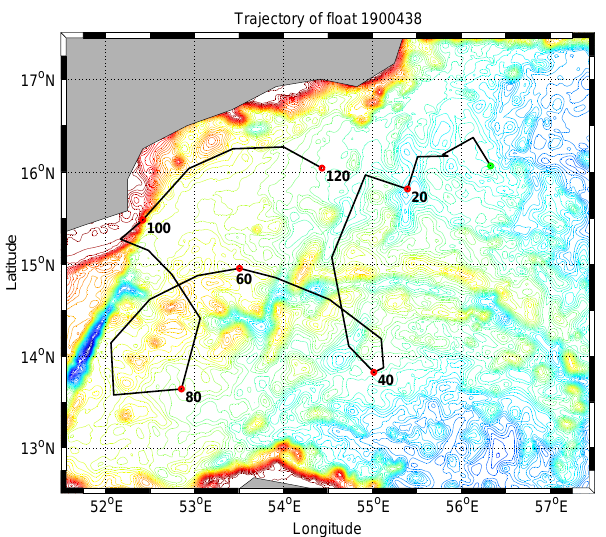
Fig. 18. Trajectory of float 1900438 in the Arabian Sea, superim- Figure 18: Trajectory of float 1900438 in the Arabian Sea, superimposed on bathymetry. A green dot indicates the initial position of the float; red dots mark the position of the posed on bathymetry. A green dot indicates the initial position of float every 20 days. the float; red dots mark the position of the float every 20 days.